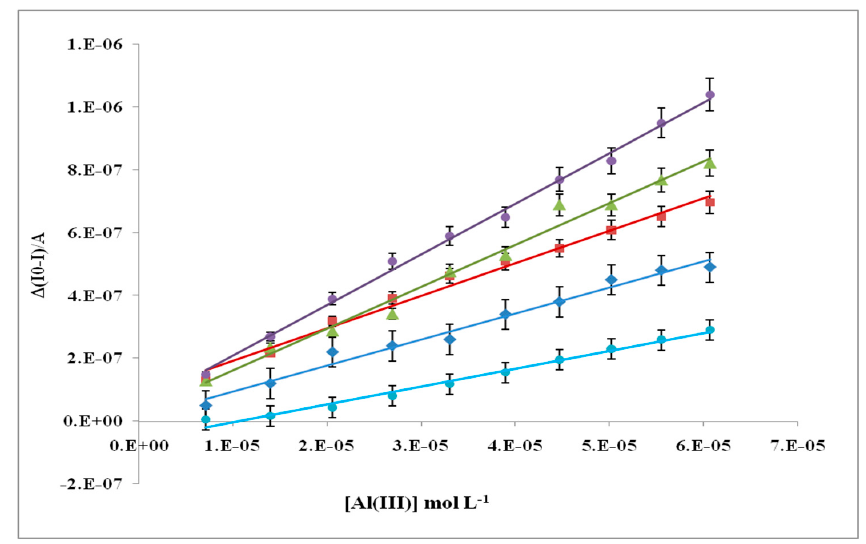
Figure 3. Calibration plots using: ( ) SOD/AuNPs/SPC TTF Es; ( ■ ) SOD/PdNPs/SPC TTF Es; ( ▲ ) SOD/RhNPs/SPC TTF Es; ( ) SOD/PtNPs/SPC TTF Es and ( ) SPC TTF Es performed with NPs/SPC TTF Es